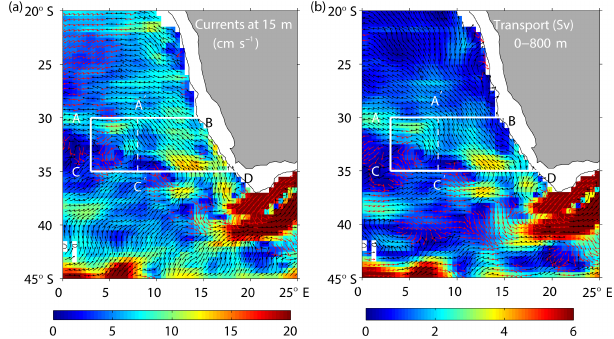
Figure 2. Climatologies of the flow at 15m (a) and transports (b) in the upper 800m from Argo & SSH. Red and black arrows indicate flow to the north and the south, respectively, and the shading rep- resents magnitude. A transport budget is derived for two regions: ABCD (extending from 3 ◦ E to the 1000m isobath near the eastern boundary) and A (cid:48) BC (cid:48) D (extending from 8 ◦ E to the 1000m isobath near the eastern